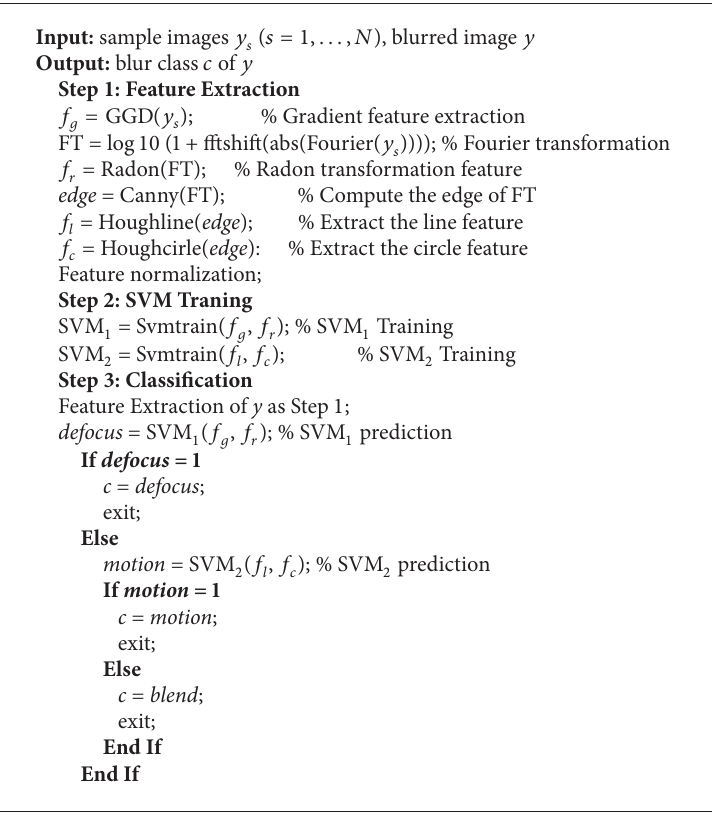
Algorithm 2: Blur classification